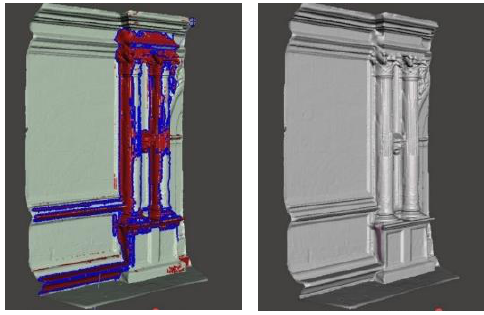
Figure 2: Digital reparation from 3dscanning, 2017.